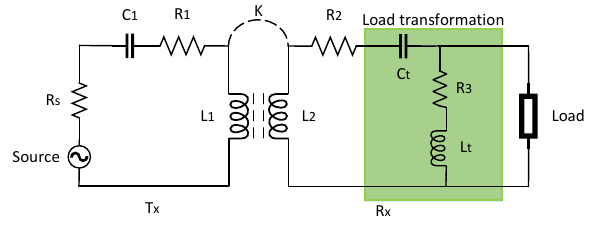
Figure 10. resonant coupling with optimal load